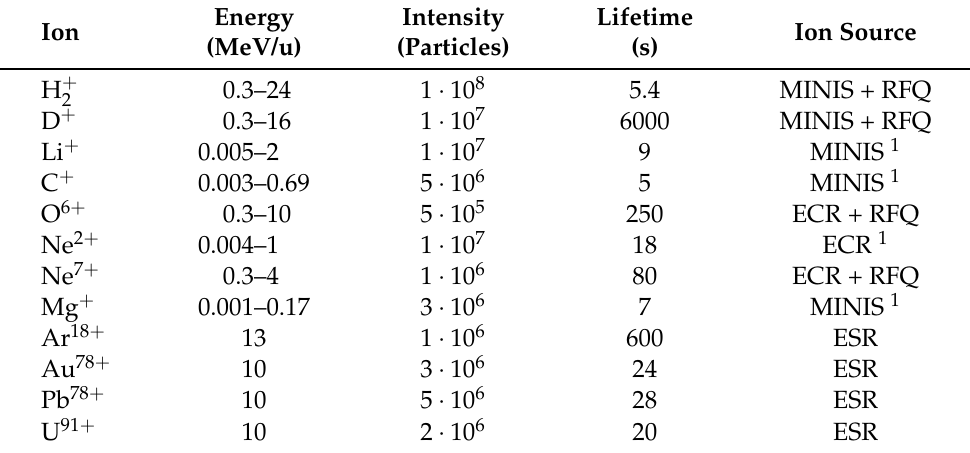
Table 1. Overview of the ion species hitherto provided in CRYRING@ESR with beam energy at injection and storage, achieved intensity, beam lifetimes at the final energy, and the ion source used for beam